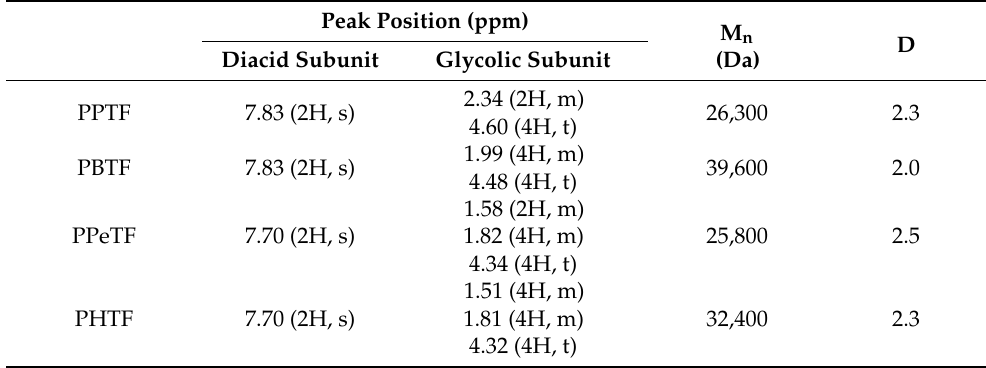
Figure 2. 1 H-NMR spectra of the homopolymers under study together with peaks’ assignment. Table 1. 1 H-NMR peak position and molecular characterisation data for the homopolymers un- der